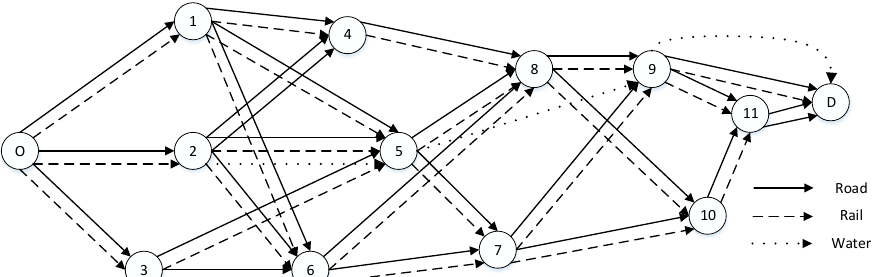
Figure 4. Schematic diagram of synchromodal transport network.